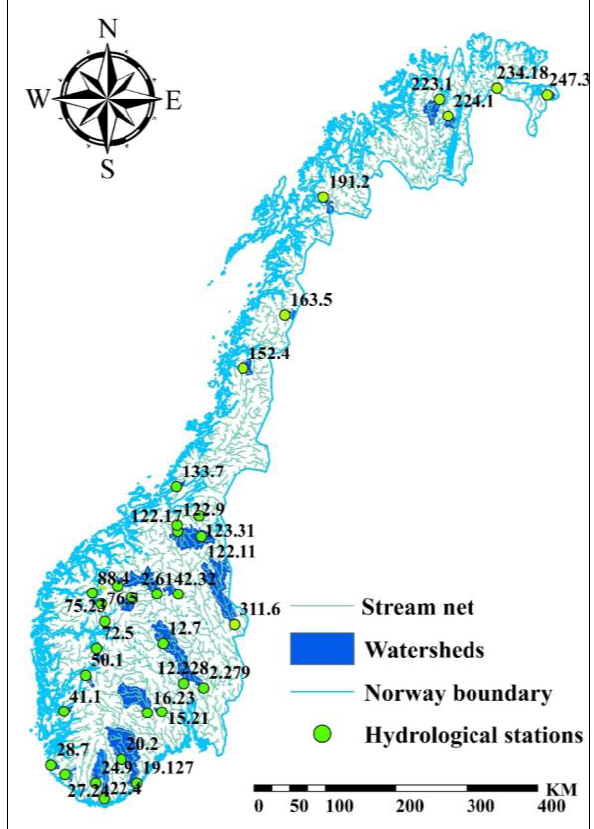
Figure 2. The location map of the 34 basins throughout Norway.